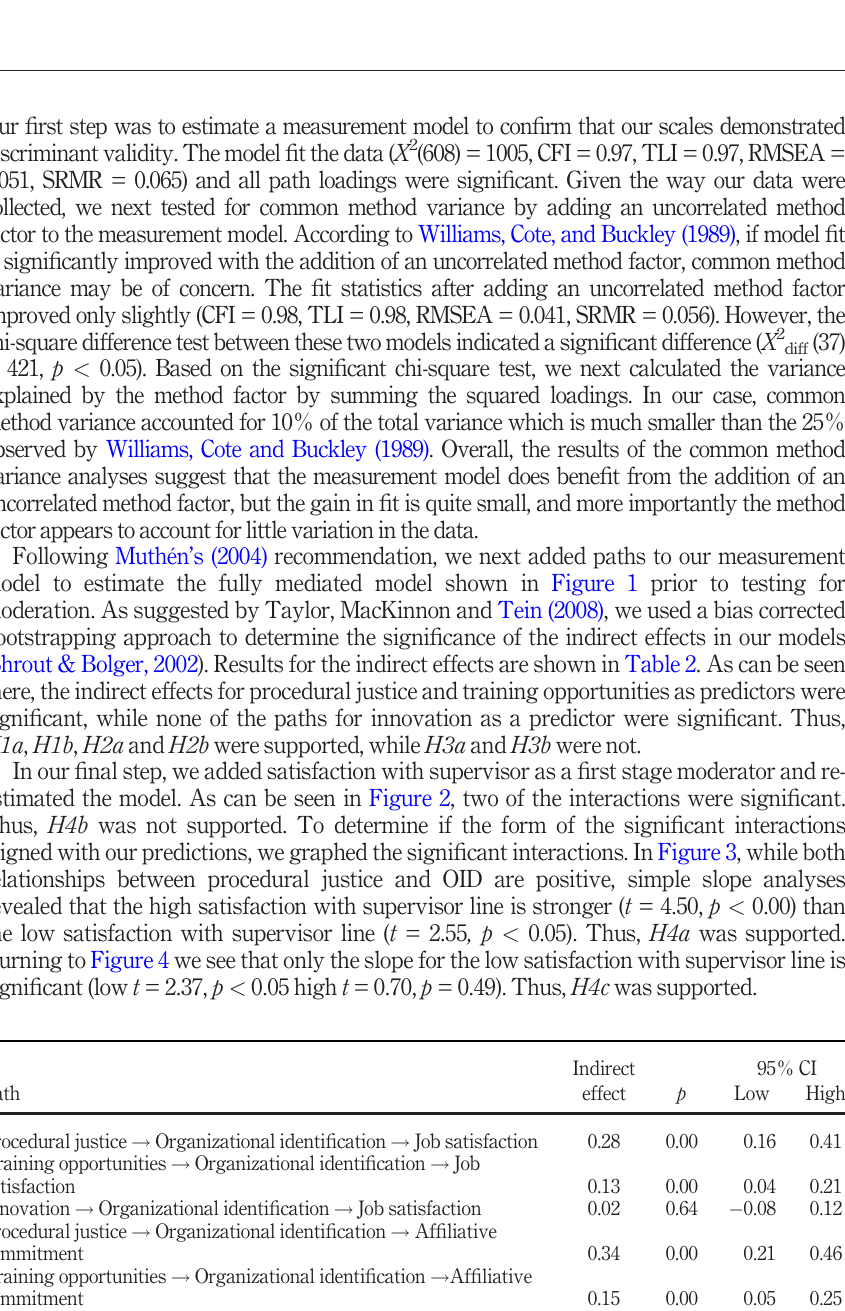
Table 2. Indirect